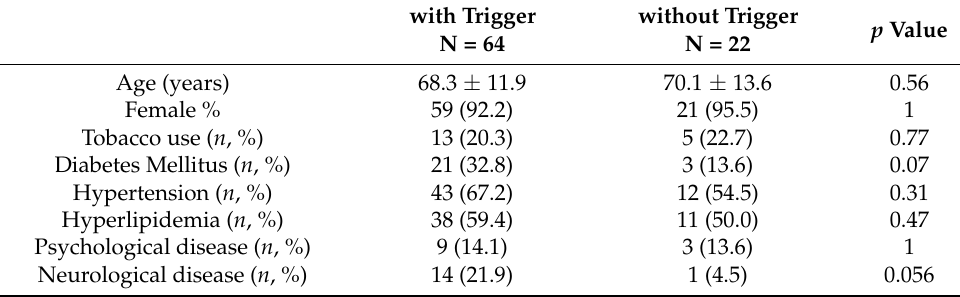
Table 3. Baseline characteristics in the two groups.